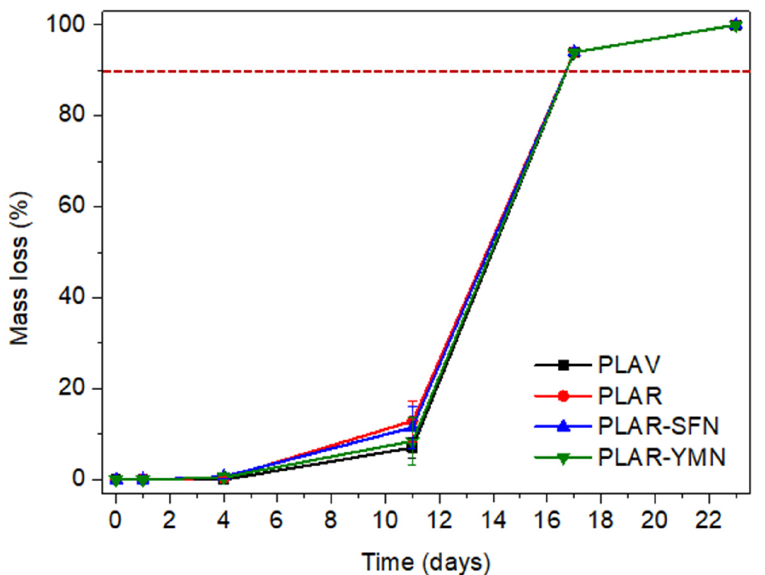
Figure 9. Degree of disintegration of films under composting conditions as a function of time.